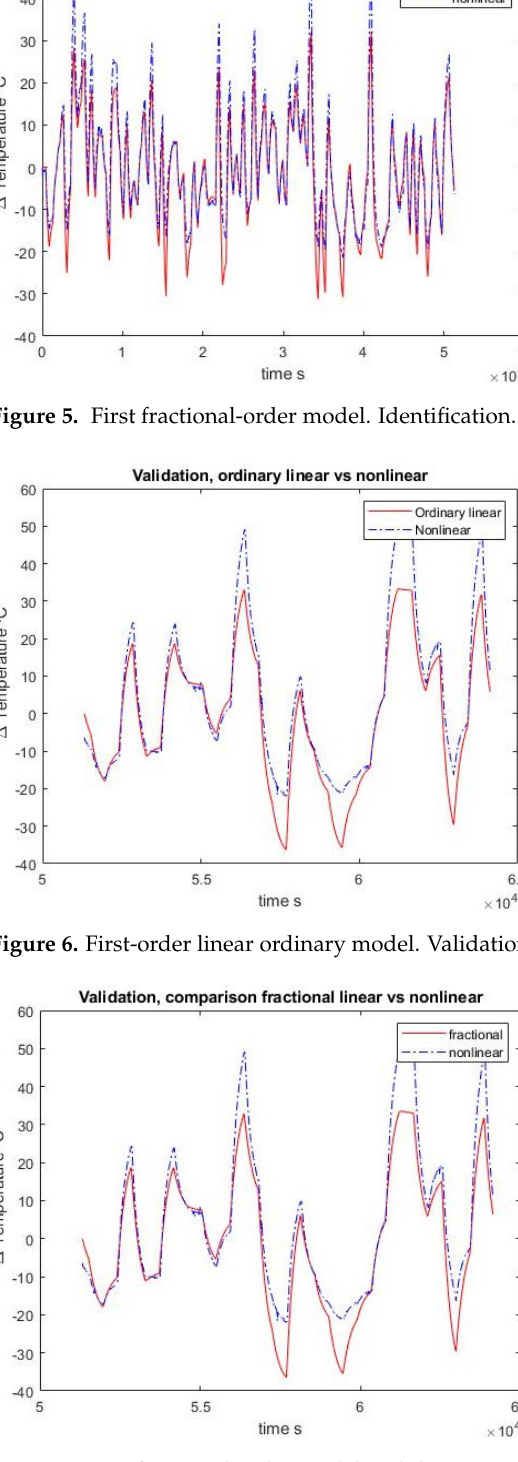
Figure 7. First fractional-order model.